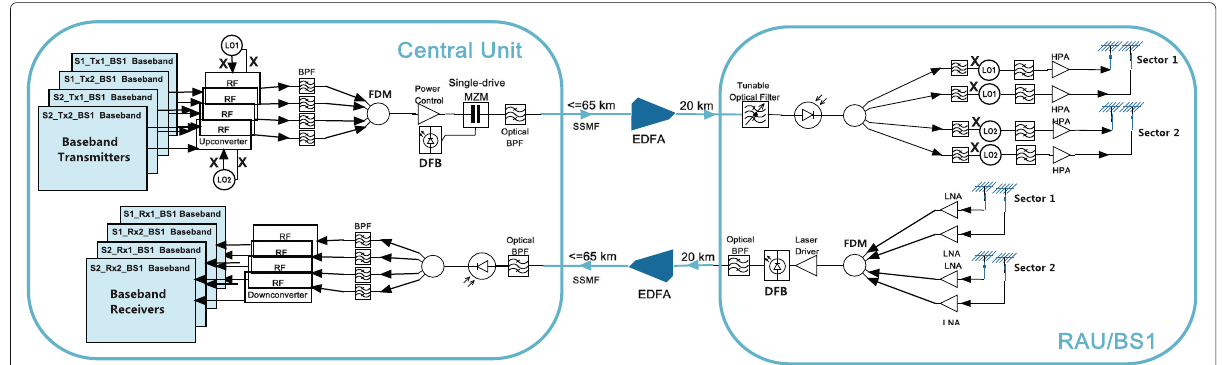
Fig. 1 Current RoF transmission